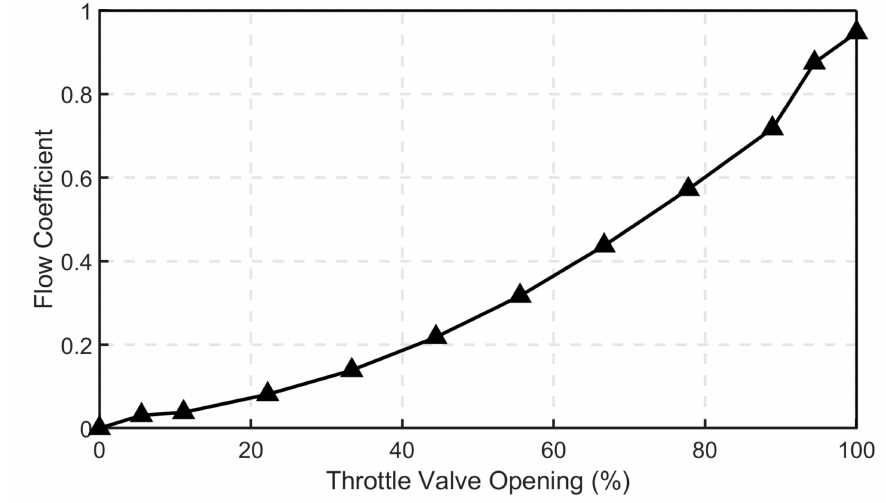
Figure 9. The variation curve of flow coe ffi cient with throttle valve